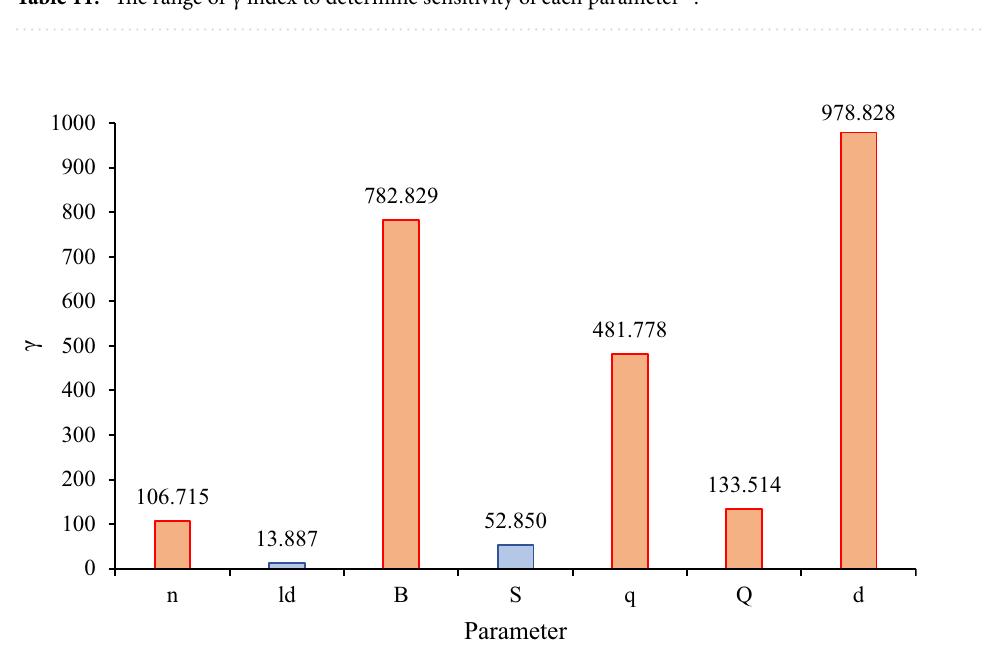
Figure 9. The impact of effective parameters on